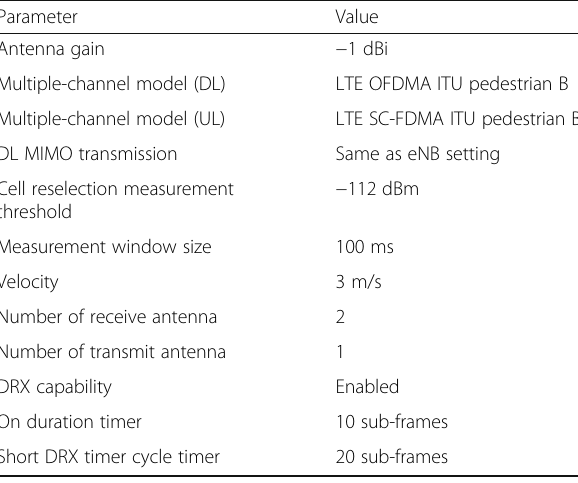
Table 6 User equipment configuration